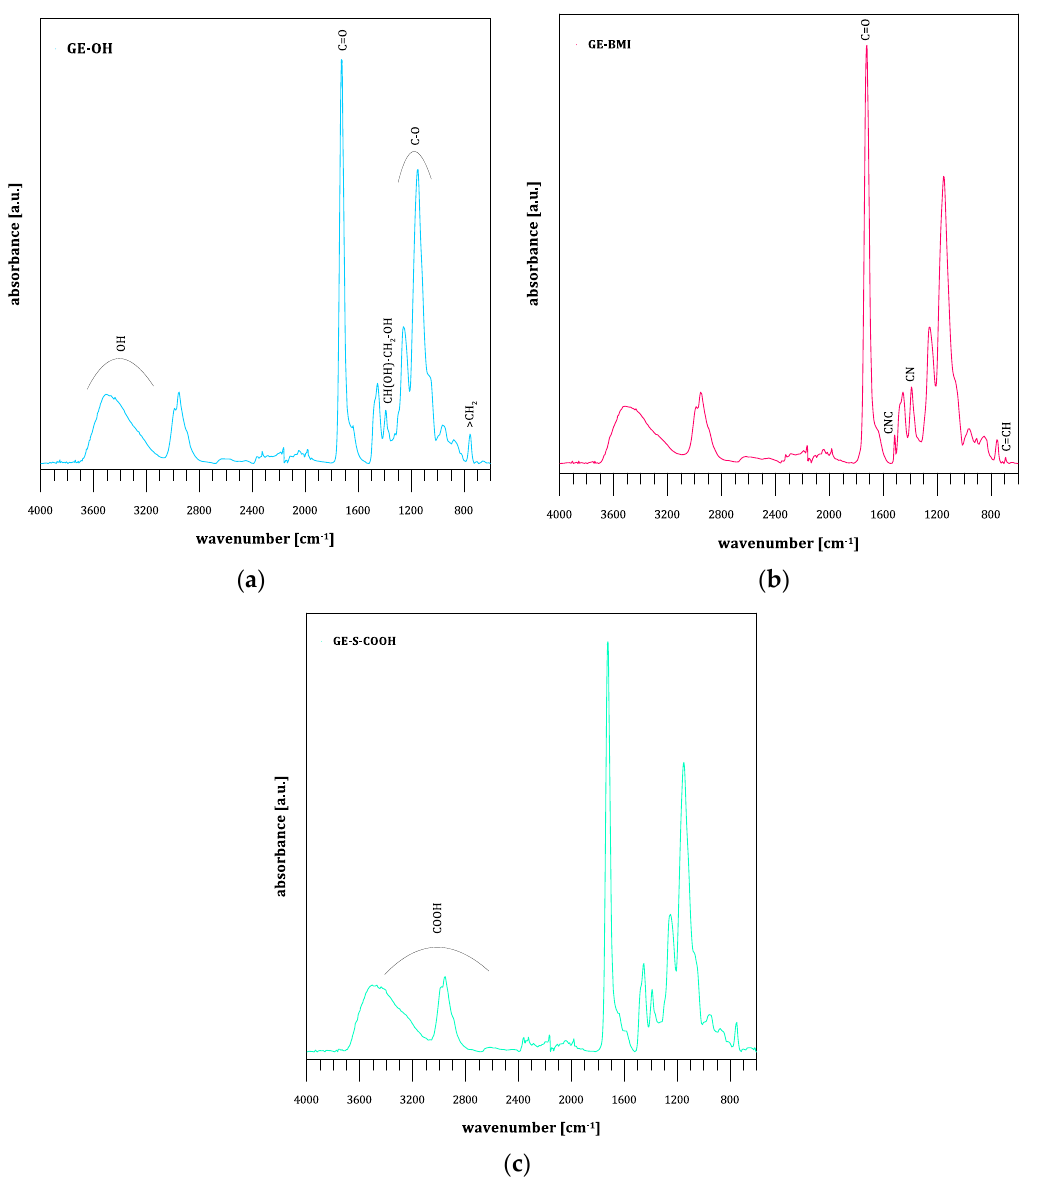
Figure 4. ATR/FT-IR spectrum of the obtained porous microspheres: ( a ) GE-OH; ( b ) GE-BMI; ( c ) GE-S-COOH.